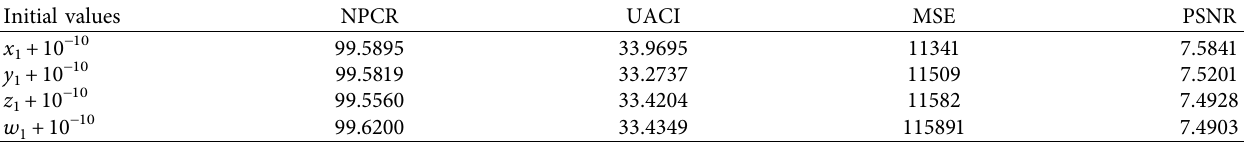
Table 3: Key sensitivity of decryption process.